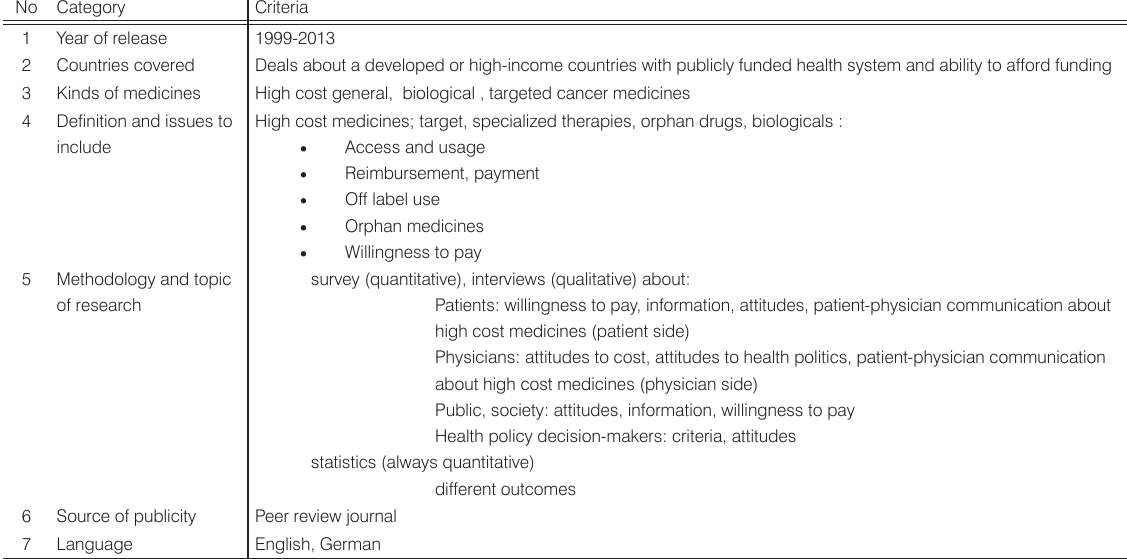
Table 1. Selection and sorting criteria for